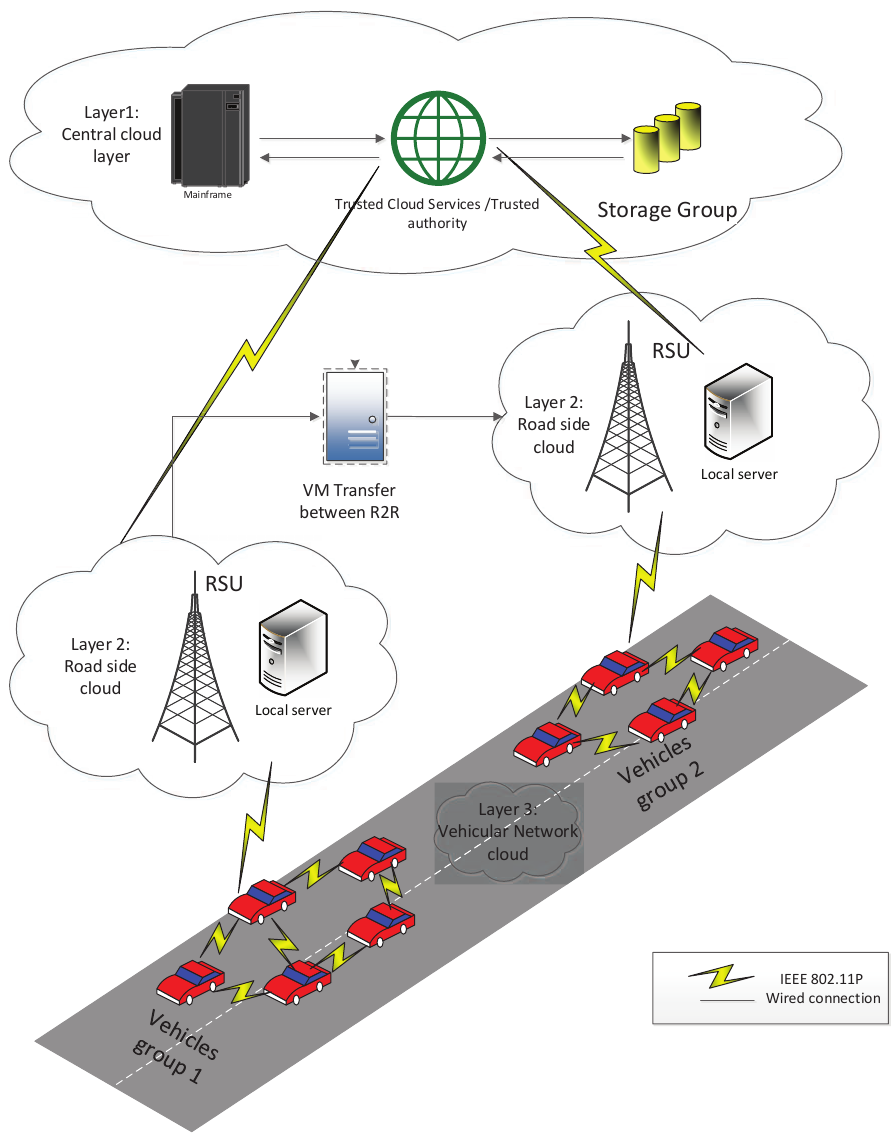
Figure 2. Three level layered Architectural network model for Vehicular ad hoc